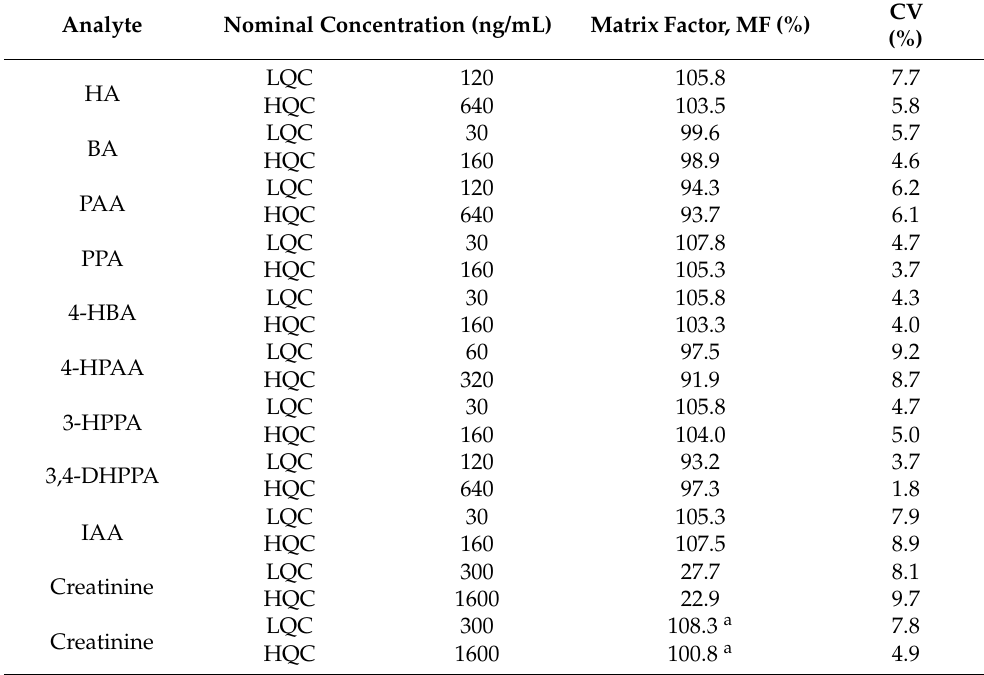
Table 4. Matrix effects of nine organic acids and creatinine from six people ( n = 6). Analyte Nominal Concentration (ng/mL) Matrix Factor, MF (%)